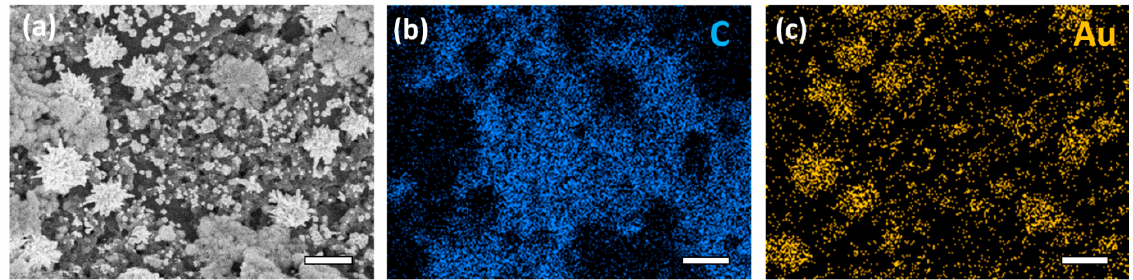
Figure 2. SEM and EDS mapping of AuNP-biopolymer composite film electrodeposited on a carbon electrode. The electron map obtained with the secondary detector is shown ( a ), with the corresponding carbon intensity map ( b ), and gold intensity map ( c ). All scale bars are 1 μ m.